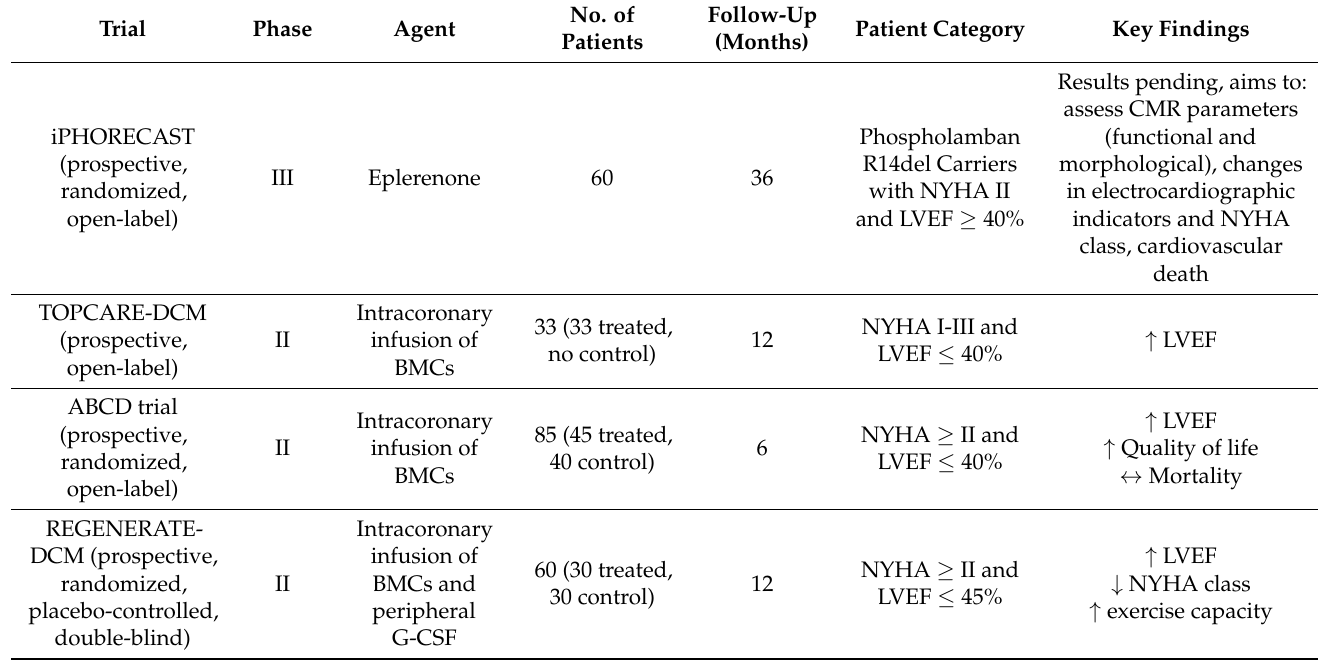
Table 3. Summary of relevant trials related to pharmacologic approaches in non-ischemic DCM.